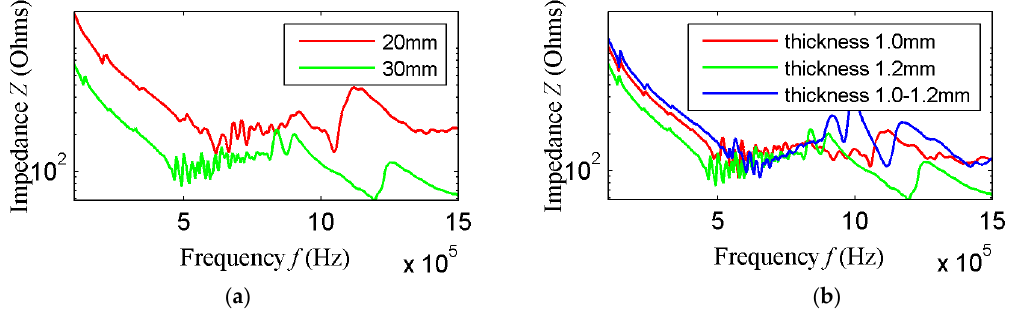
Figure 11. Impedance analysis experimental result of array element one; ( a ) Impedance analysis results of different lengths array element of thickness 1.2 mm; and ( b ) Impedance analysis results of length 30 mm array element with different thickness.